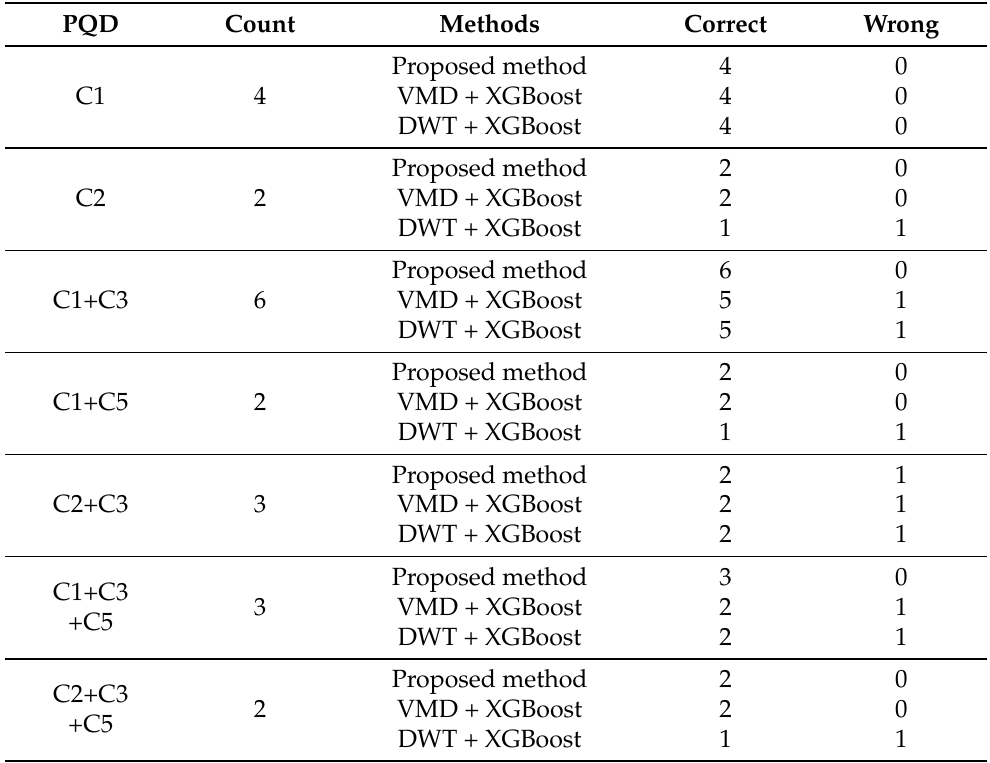
Table 5. Classification results of measured PQD